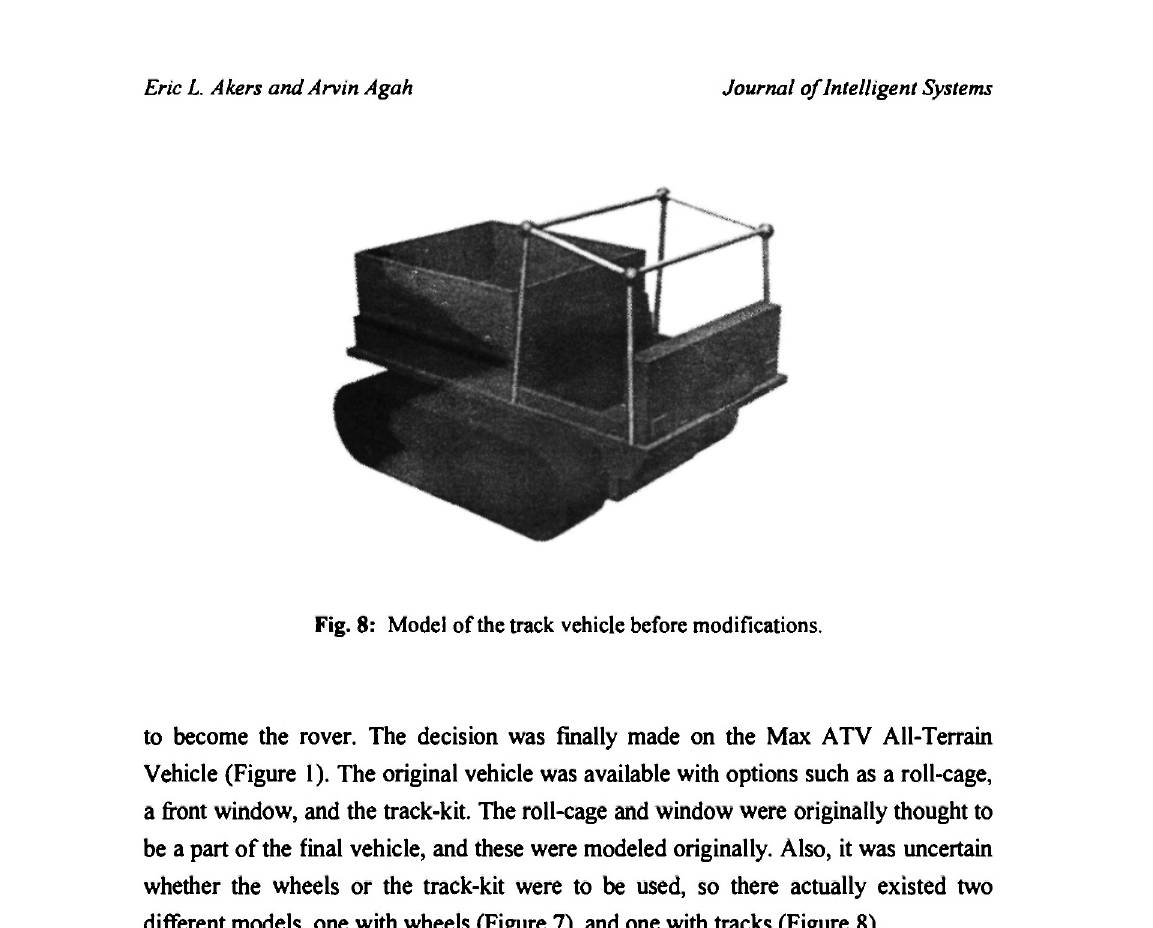
Fig. 8: Model of the track vehicle before